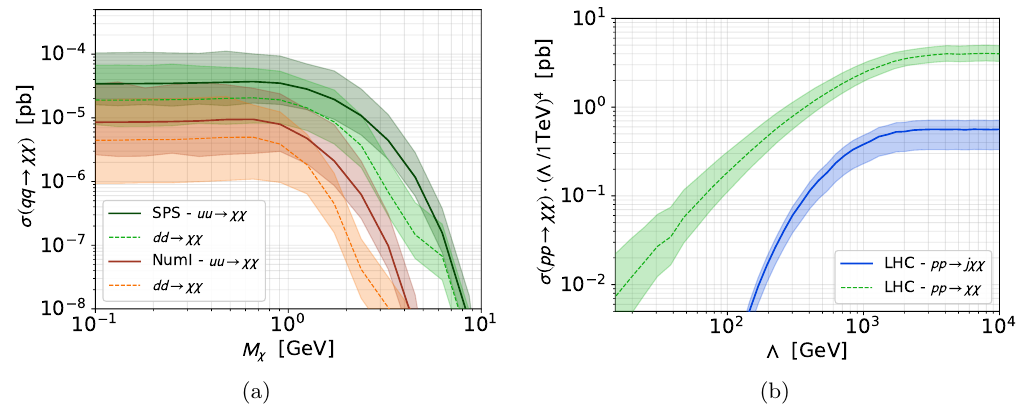
Figure 3 . (a) Cross-sections for the proton partonic production processes at (cid:3) = 1 TeV for u (cid:22) u; d (cid:22) d ! (cid:31) (cid:22) (cid:31) for the SPS (400 GeV) beam and for the NuMI (120 GeV) beam (b) Cross-section times (cid:3) 4 at LHC for pp ! (cid:31) (cid:22) (cid:31) + jets as a function of the new physics scale (cid:3). In both cases, the theoretical errors on the cross-section are obtained by varying the renormalisation scale by a factor of 2 or 1 = 2 with MadGraph